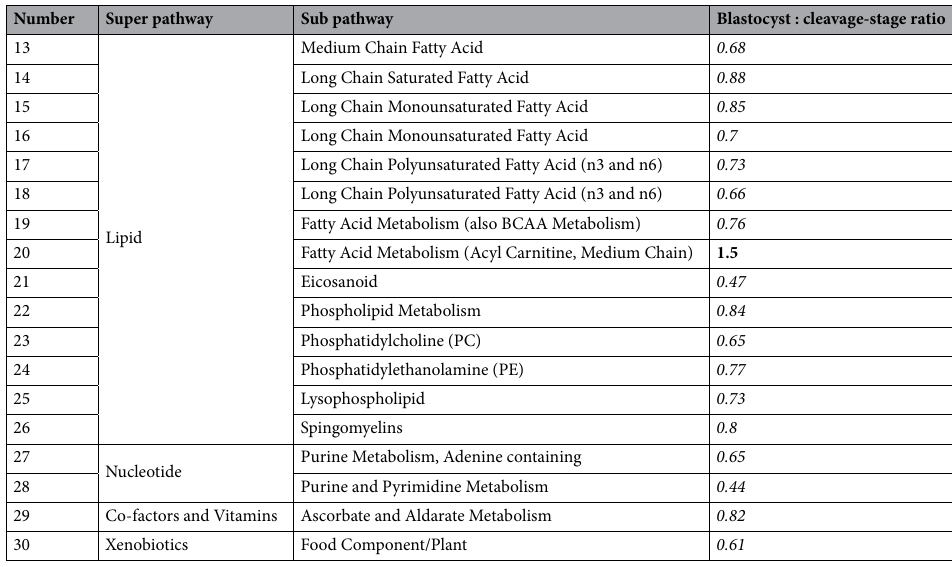
Table 1. List of metabolite-based pathways that significantly differ between embryo groups. Bold indicates significant difference ( p ≤ 0.05) between the groups shown; metabolite ratio of ≥ 1.00. Italics indicates significant difference ( p ≤ 0.05) between the groups shown, metabolite ratio of <